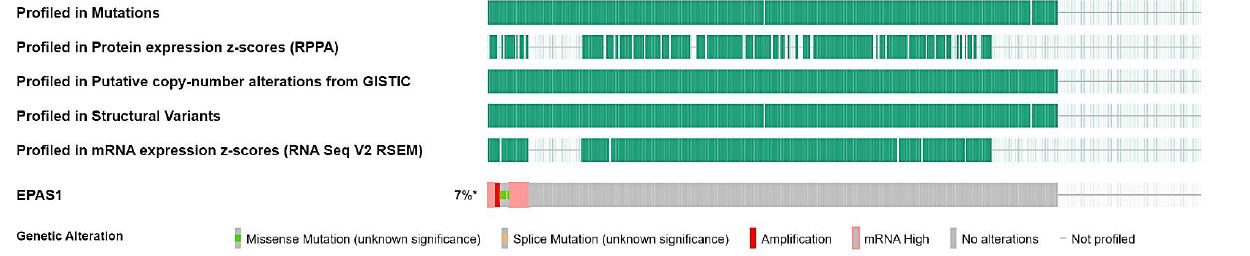
Figure 2. Oncoplot of EPAS1 molecular alterations in MSK/TCGA 2020 cohort (n = 476). * al- tered/profiled: 27/380.